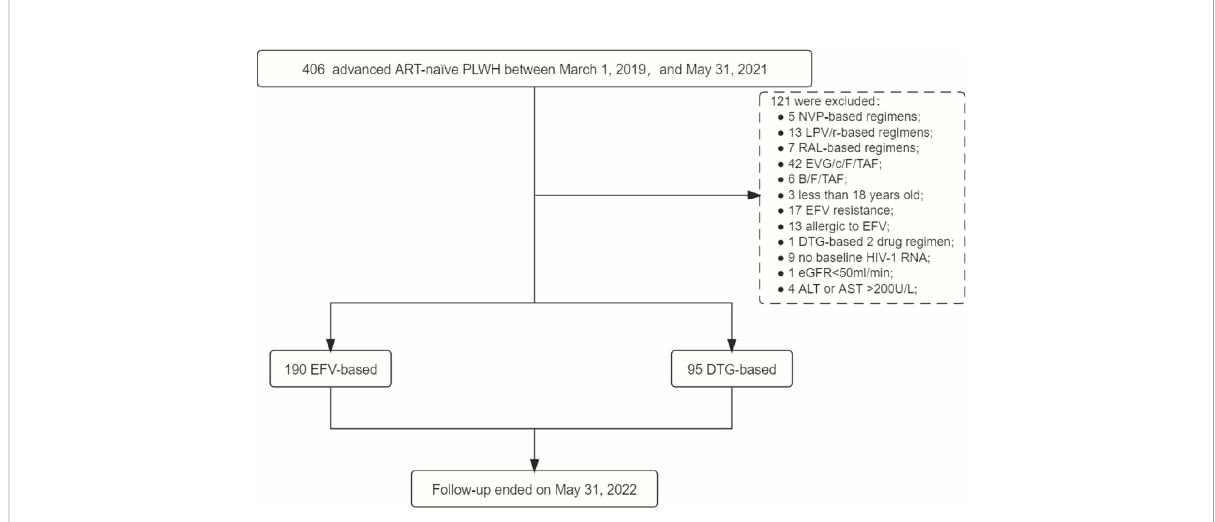
FIGURE 1 Study process. ART, antiretroviral therapy; PLWH, people living with HIV; NVP, nevirapine; LPV/r, lopinave/litonawe; RAL, raltegravir; EVG/c/F/ TAF, elvitegravir/cobicistat/emtricitabine/tenofovir alafenamide; B/F/TAF, bictegravir/emtricitabine/tenofovir alafenamide; EFV, efavirenz; DTG, dolutegravir; eGFR, estimated glomerular fi ltration rate; ALT, alanine transaminase; AST, aspartate